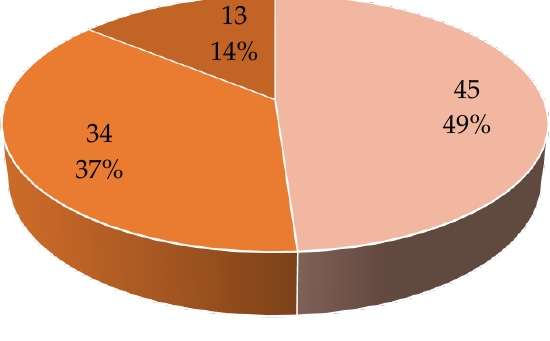
Figure 17. Rehabilitation vs assistance or both.